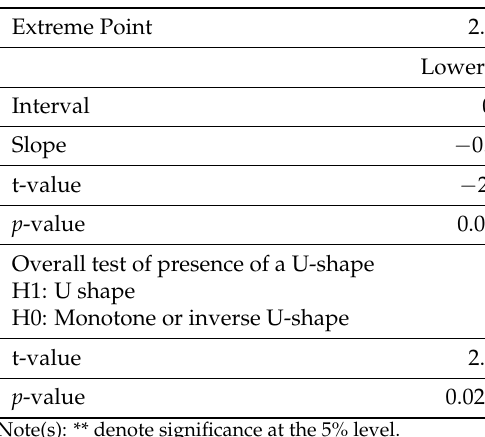
Table 6. Results of